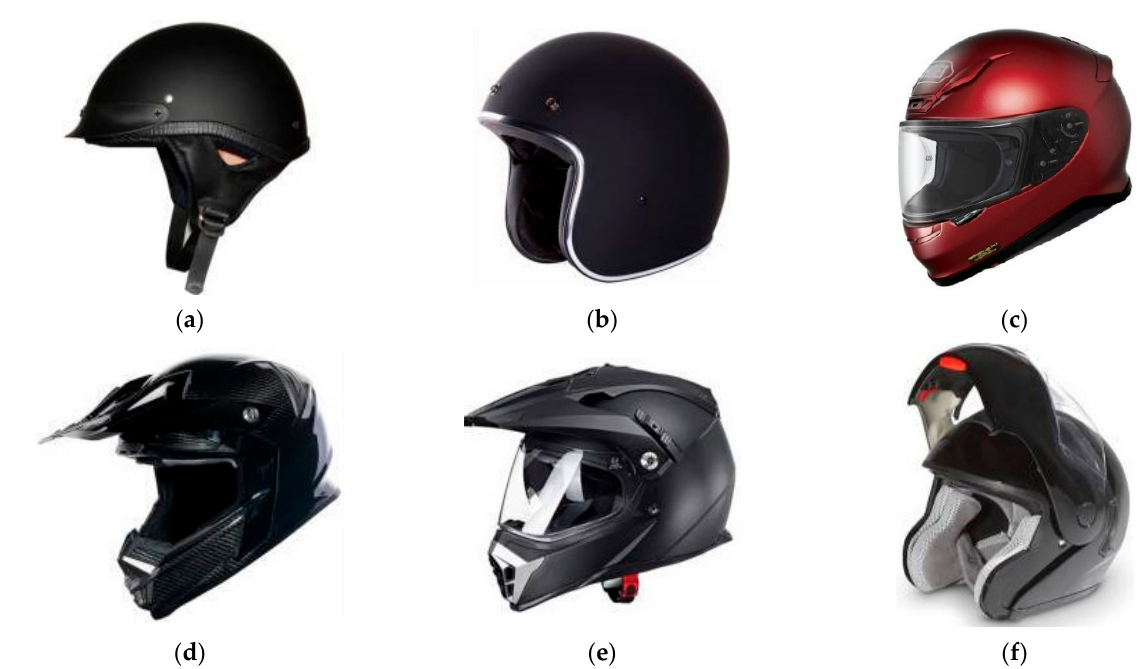
Figure 1. Types of helmet used by e-bike riders. ( a ) Half helmet, ( b ) three-quarters helmet, ( c ) full-face helmet, ( d ) off-road helmet, ( e ) tour-cross helmet, ( f ) flip-up helmet.